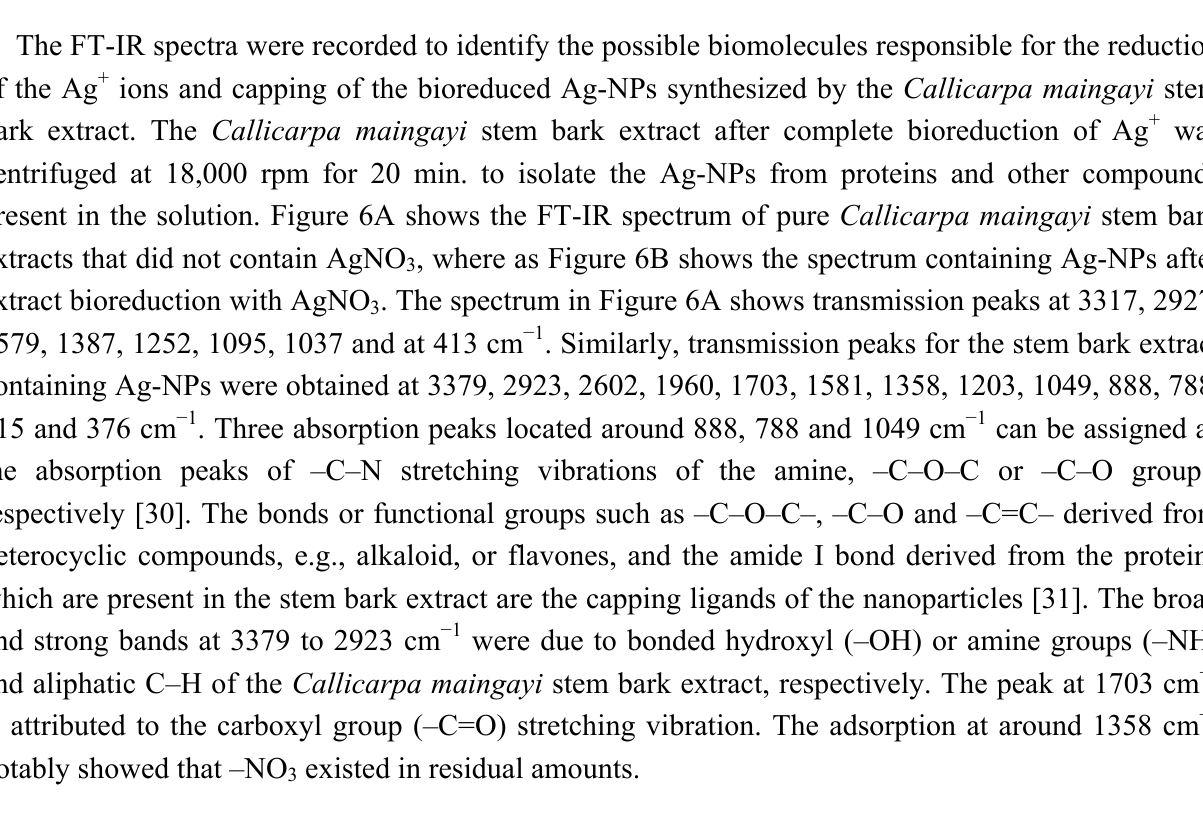
Figure 6. FT-IR spectra for the Callicarpa maingayi ( A ) and Ag/ Callicarpa maingayi stem bark ( B ) after 48 h from biosynthesis